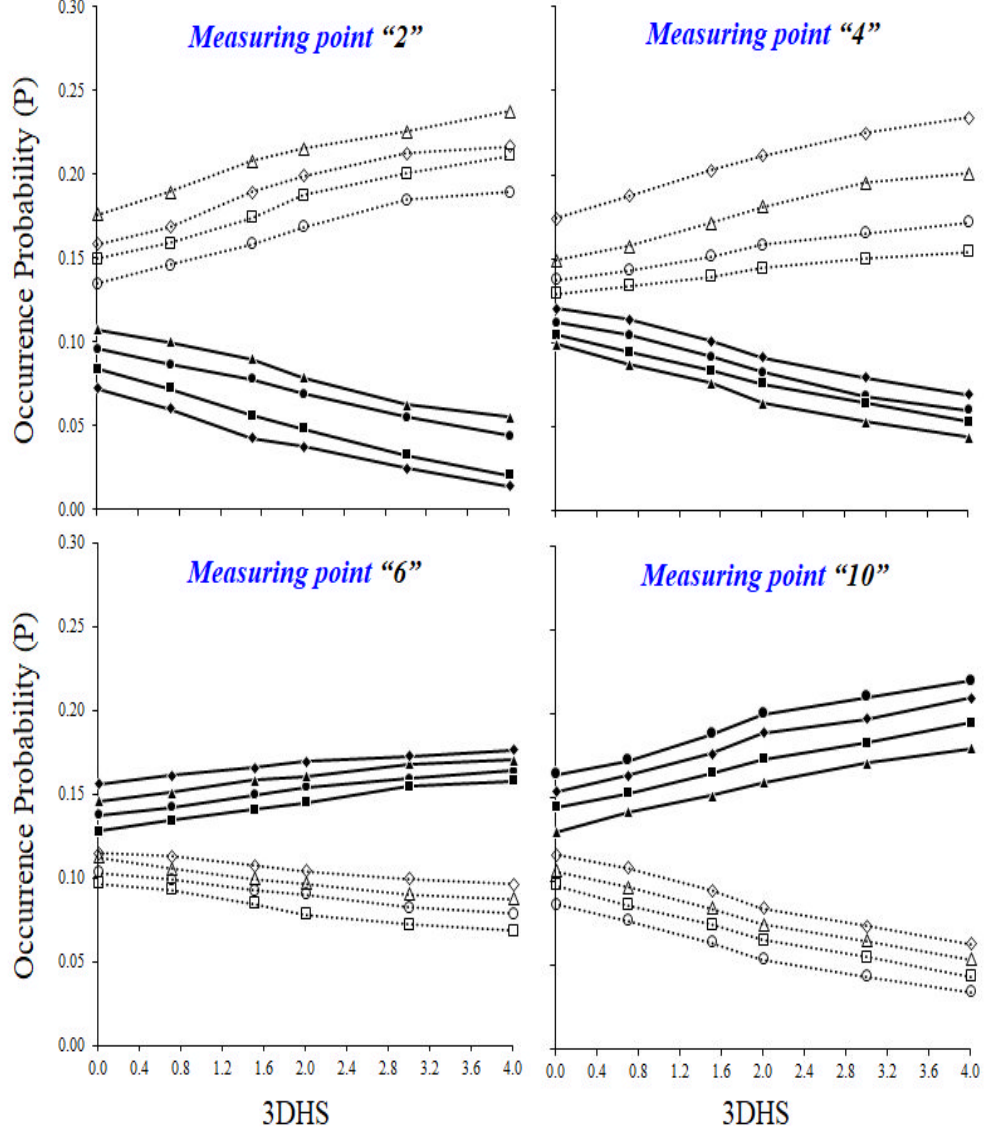
Figure 12. Depth-averaged occurrence probabilities of the octagonal bursting events with 3DHS values for the experimental run 2R: P 1 (filled circles), P 2 (unfilled circles), P 3 (filled squares), P 4 (unfilled squares), P 5 (filled triangles), P 6 (unfilled triangles), P 7 (filled diamonds), and P 8 (unfilled diamonds). Continuous lines indicate odd octagonal events, while dashed lines denote even events.